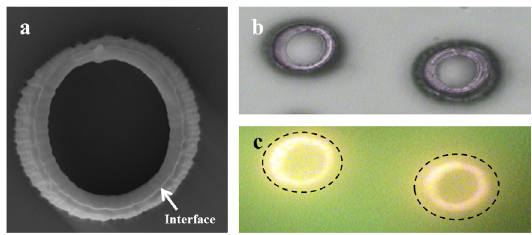
Figure 8. (a) SEM and (b) optical image (top view) of the cylindrical microstructures, displaying the interface between the cylindrical shells. (c) Fluorescence image of the microstructure upon excitation with an LED centered at 450 nm. The contour of the undoped region is represented by the dotted